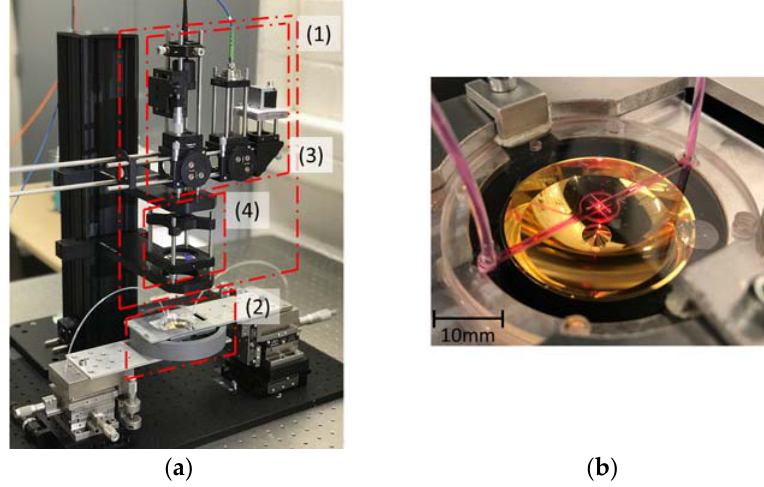
Figure 5. Proof ‐ of ‐ concept demonstration setup of our Raman spectroscopy system ( a